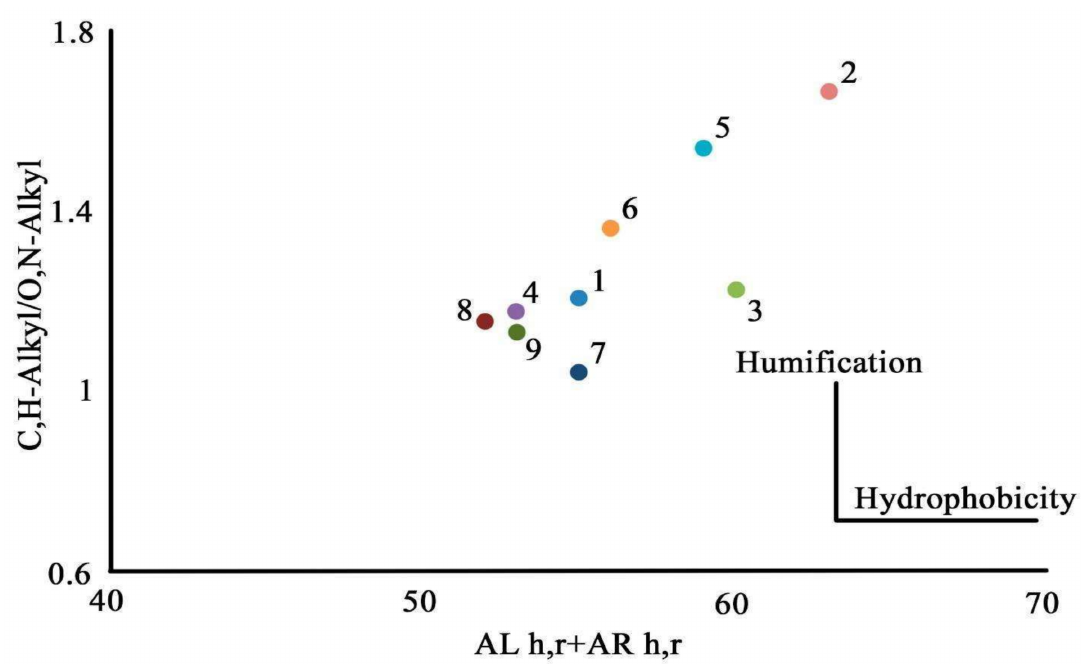
Figure 6. The diagram of integrated indicators of the molecular composition of HAs. Samples correspond to Table